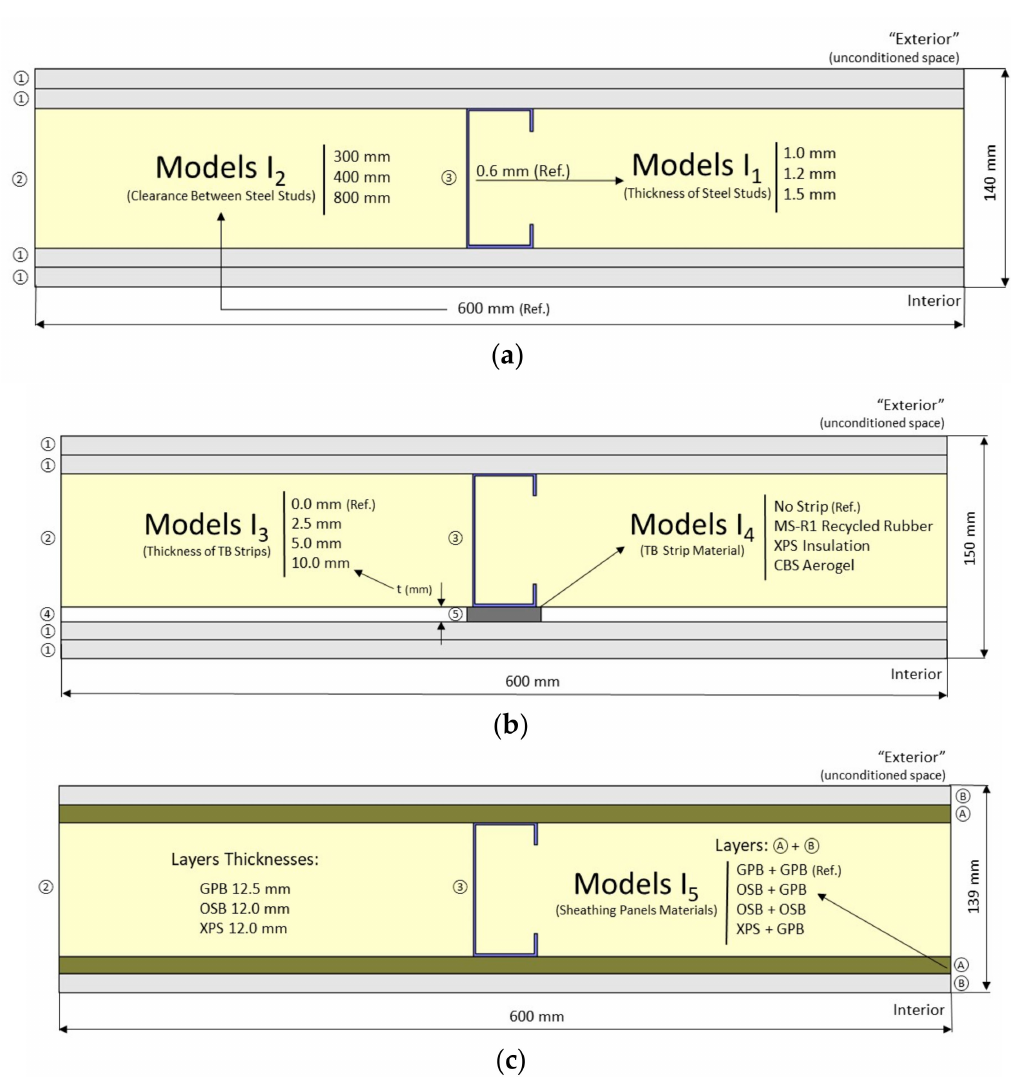
Figure 3. Interior LSF partition cross-sections: ( a ) Models I1 and I2; ( b ) Models I3 and I4; ( c ) Model I5. Layers: 1 (cid:79) gypsum plasterboard (GPB); 2 (cid:79) mineral wool; 3 (cid:79) steel stud C90; 4 (cid:79) air layer; 5 (cid:79) TB